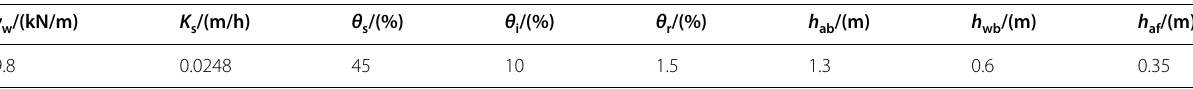
Table 4 Hydraulic